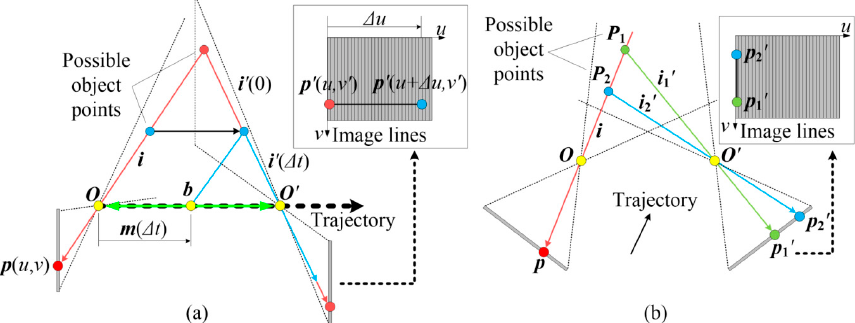
Figure 4. Ideal stereo configurations. ( a ) Direction of the trajectory is always consistent with the base vector; and ( b ) the two viewing planes are